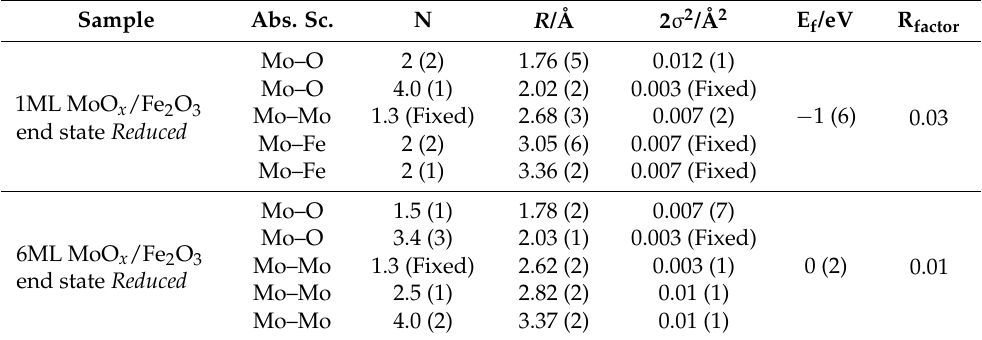
Table 3. EXAFS fitting parameters for the 1 and 6ML MoO x /Fe 2 O 3 reduced under MeOH/He at 350 ˝ C. The R factor for the 1 and 6ML reduced MoO x /Fe 2 O 3 catalysts were 0.03 and 0.01 respectively.